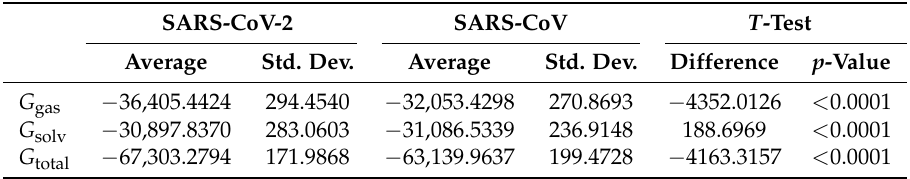
Table 2. The free energies calculated from MD simulations for the spike proteins of SARS-CoV-2 and SARS-CoV, where G gas is the interaction energy in the gas and G solv is the solvation energy in the solvent, respectively. All units are reported in kcal/mol. The t -test was conducted to check the statistical significance of the difference between two sets of free energies. A p -value of < 0.05 indicates that the difference is statistically significant (95% confidence